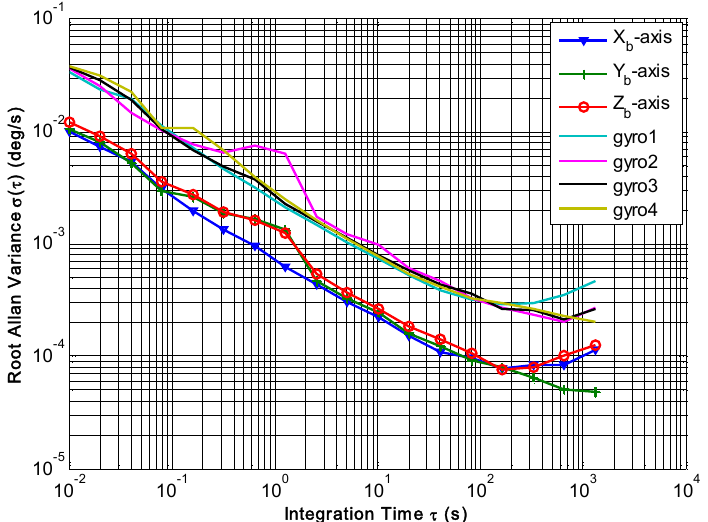
Figure 22. Plot of Allan variance between the gyros and fused signal rate in MIMU’s body coordi-